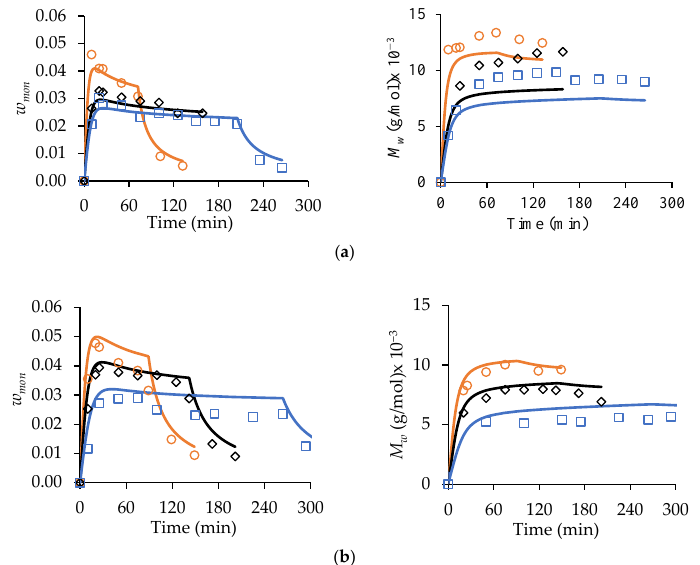
Figure 7. A comparison of experimental (symbols) and simulated (lines) profiles of w mon (left-hand column of plots) and polymer M w (right-hand plots) from MA/t-BuAAm starved-feed semi-batch copolymerizations conducted at 70 °C, with w mon,tot = 0.20, 2.0 wt% AIBN, and f MA, 0 = 0.50: ( a ) α EtOH = 0.75 and ( b ) α EtOH = 1. The feed times used are 75 min ( ○ ), 150 min ( ◇ ), and 225 min ( ☐ ). Solid lines are simulated results from PREDICI ® using parameters in Tables S2 and S3.